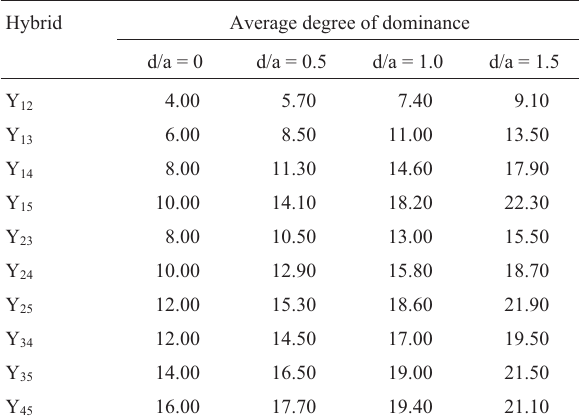
Table 2 - Hybrids’ mean genotypic value, simulated for several average degrees of dominance.